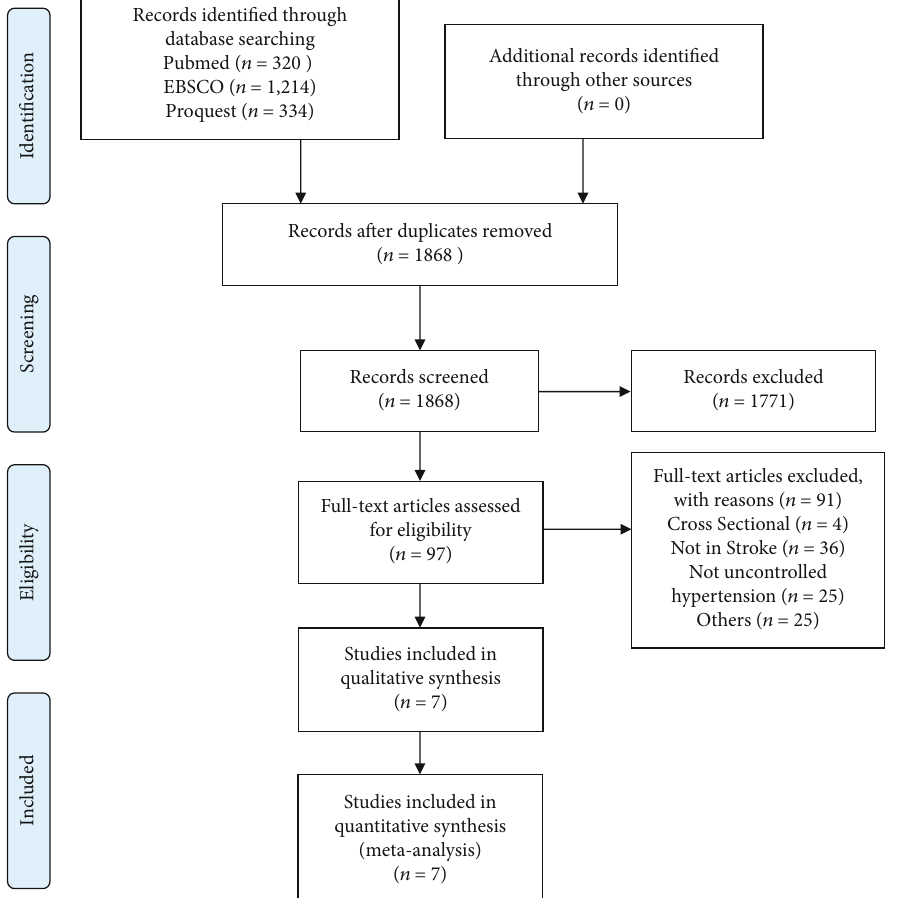
Figure 1: Flow diagram on the selection processes examining the risk factors of uncontrolled hypertension in